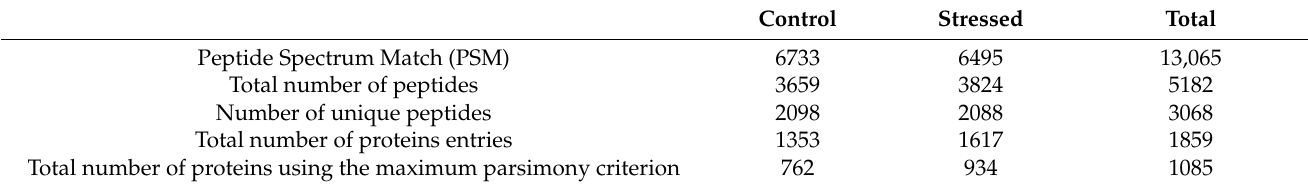
Table 1. Absolute numbers of all peptides and proteins identified via proteomics analysis in the leaves of young oil palm plants submitted to drought stress. Control Stressed Total Peptide Spectrum Match